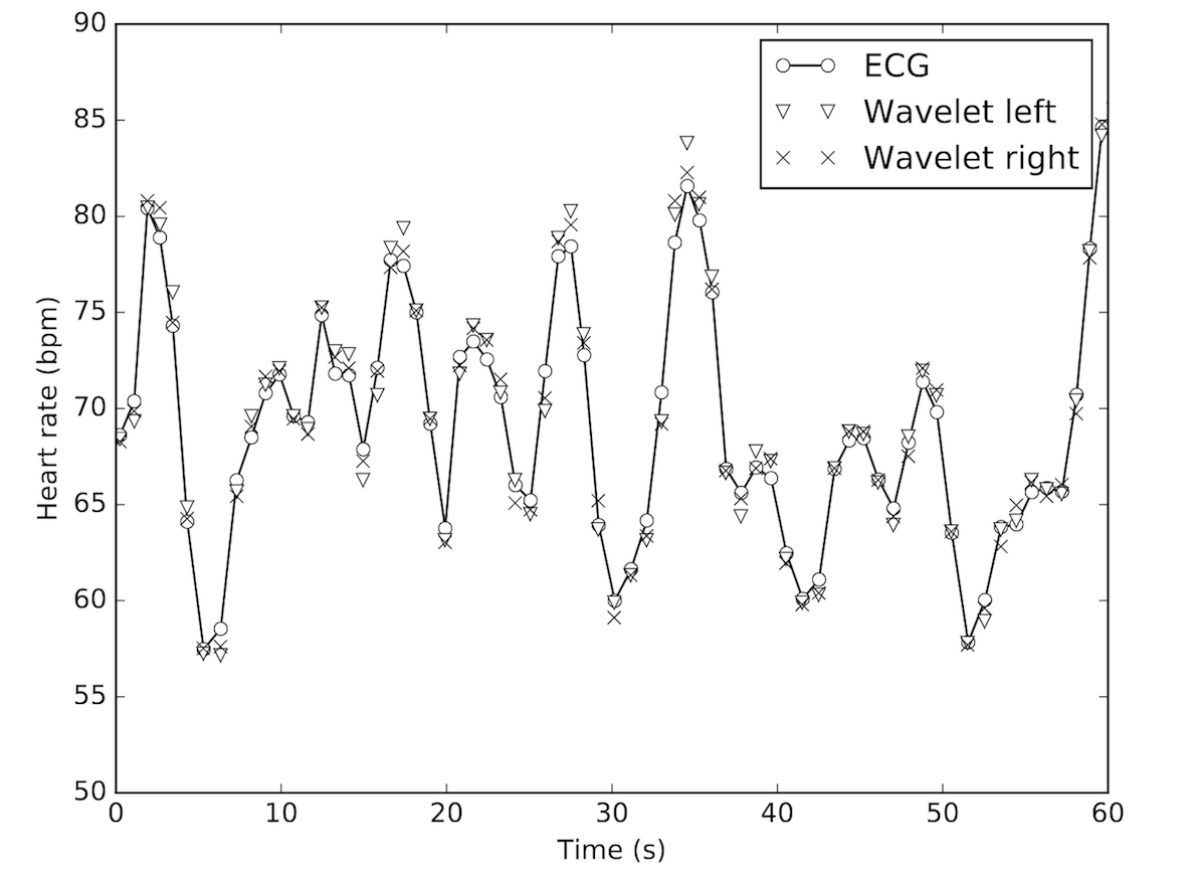
Figure 4. Representative instantaneous heart rate (HR) estimates from the wristbands on the left and right wrists show good agreement with the electrocardiography (ECG) HR measurements. Note that the beat-level HR data are computed in the background to estimate 60-second window HR averages reported in this study. Wavelet 1 and 2 labels refer to the wristband placed on the left and right wrists,